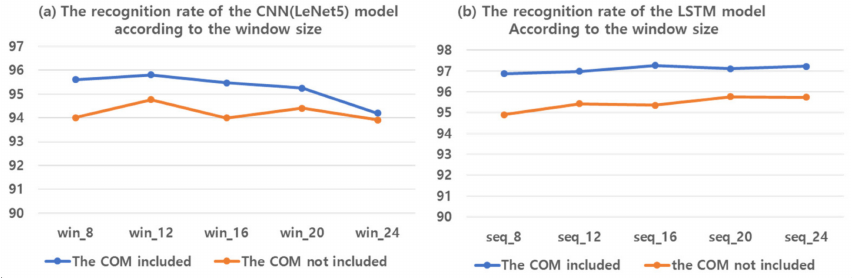
Figure 8. Results of recognition rates of CNN and LSTM